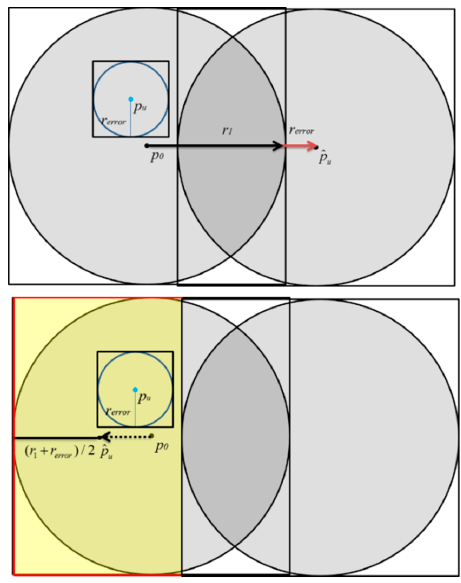
Figure 8. The effect of r error on the localization results of ESPAA. Figure 8. The e ff ect of r error on the localization results of ESPAA. Table 1. The Pseudo-code of Error-Adjusted Space Partition Attack Algorithm.